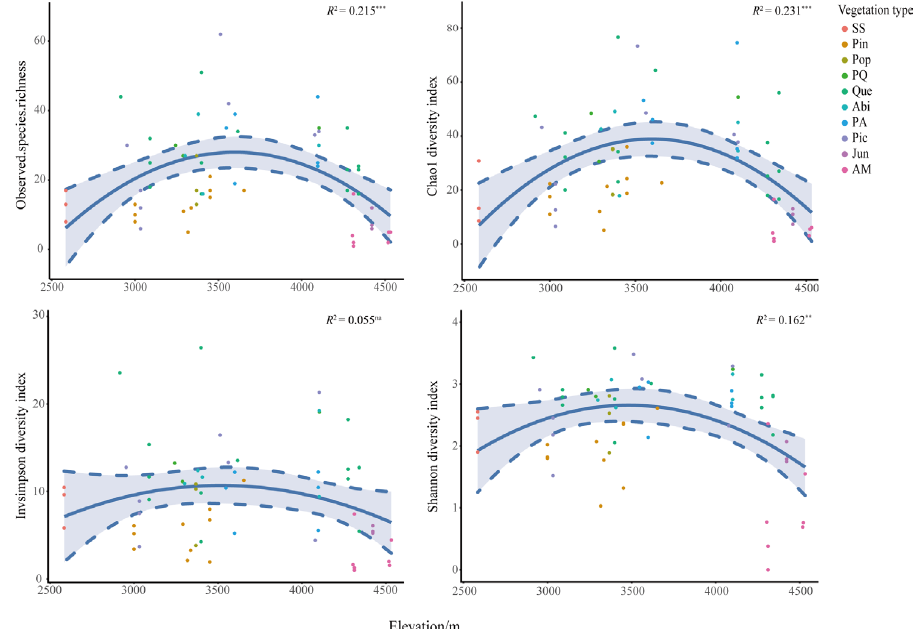
Figure 7. Variation of macrofungal observed species richness along the elevation gradient. R 2 , adjustment r squared of the regression equation; na, p value of the regression equation ( p ) is greater than 0.05; **, p is less than 0.01; ***, p is less than 0.001; gray areas are the 95% confidence intervals. Each point corresponds to a different sample with colors indicating vegetation type.